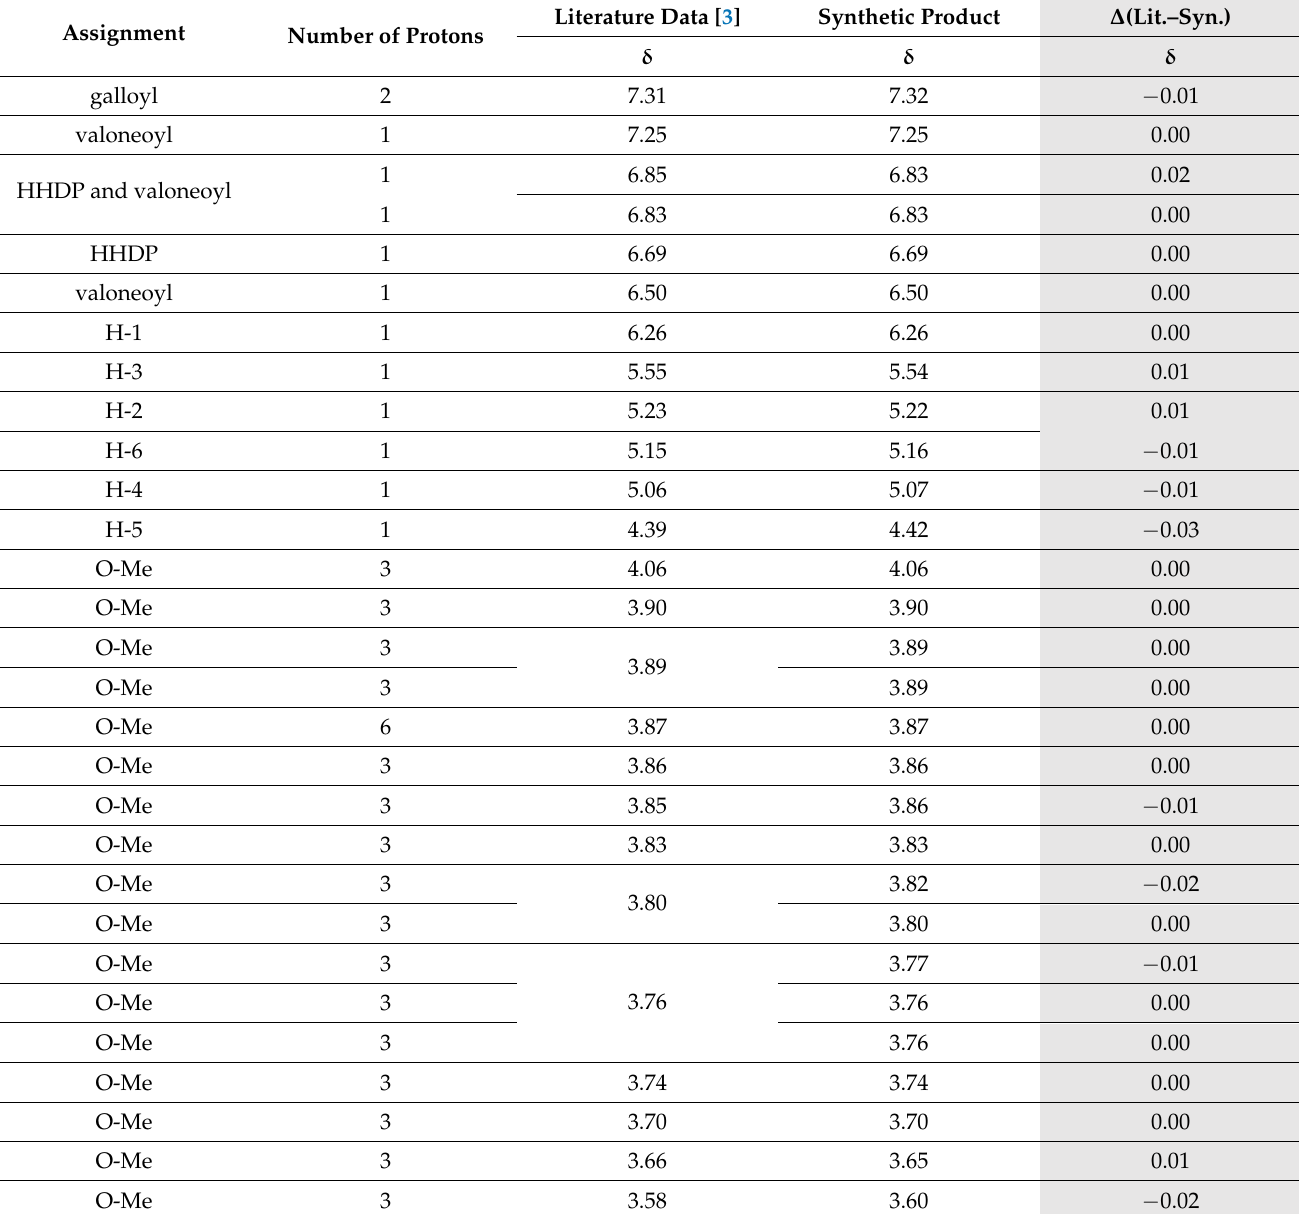
Table A5. Comparison of the 1 H NMR spectral data between the synthetic compound 32 and the literature data